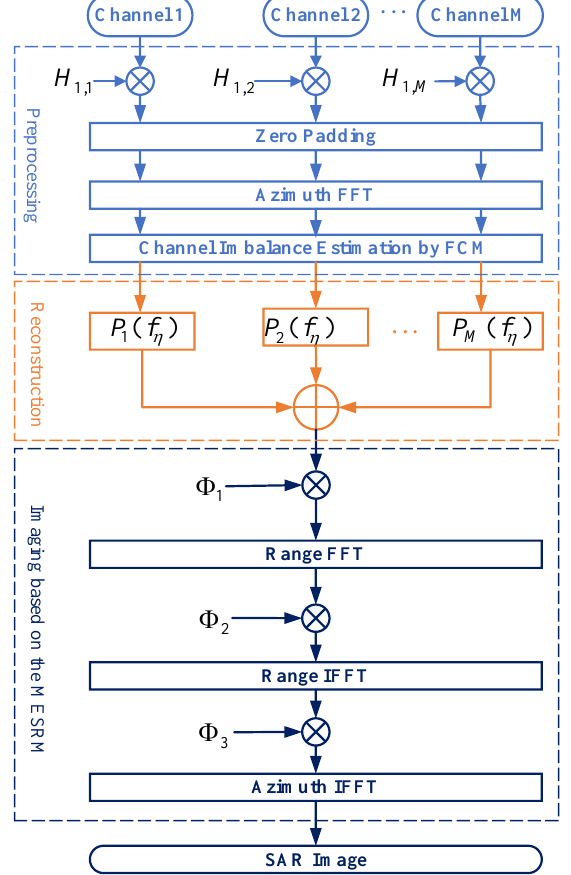
Figure 6. The overall imaging scheme proposed in this paper.